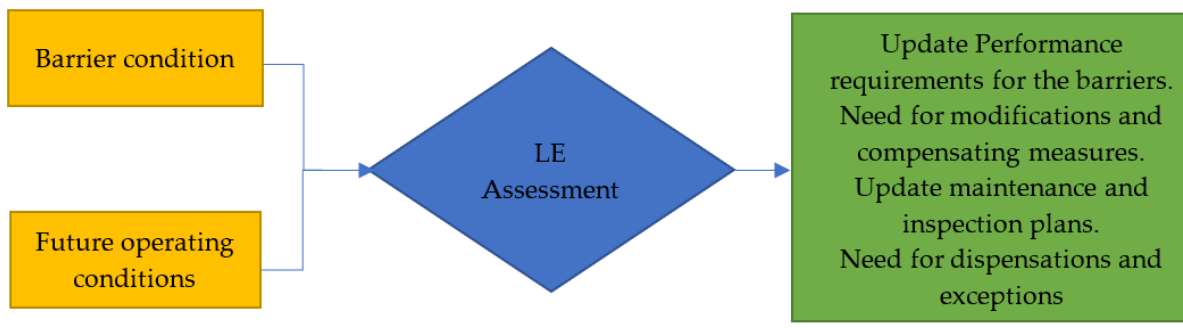
Figure 6. Recommended life extension assessments of barriers.